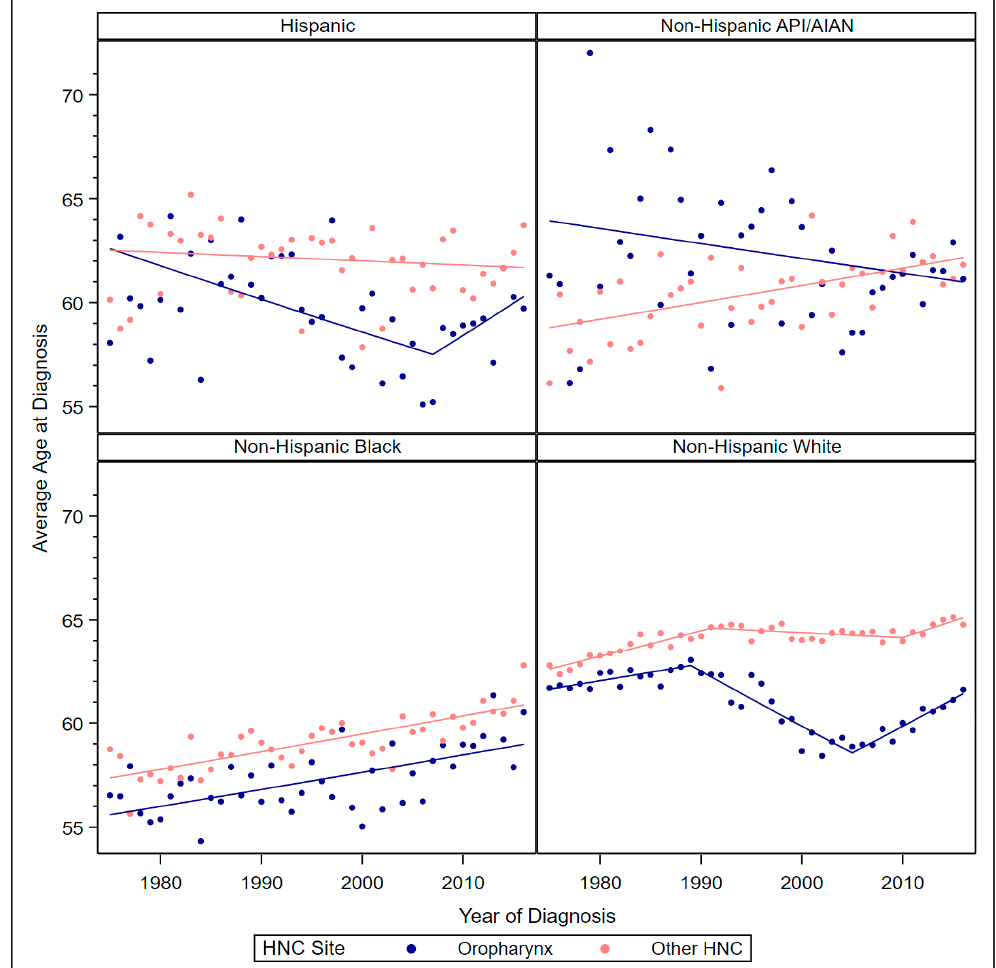
Figure 3. Observed average age at diagnosis by year and Joinpoint regression models by race/ethnicity and HNC site.